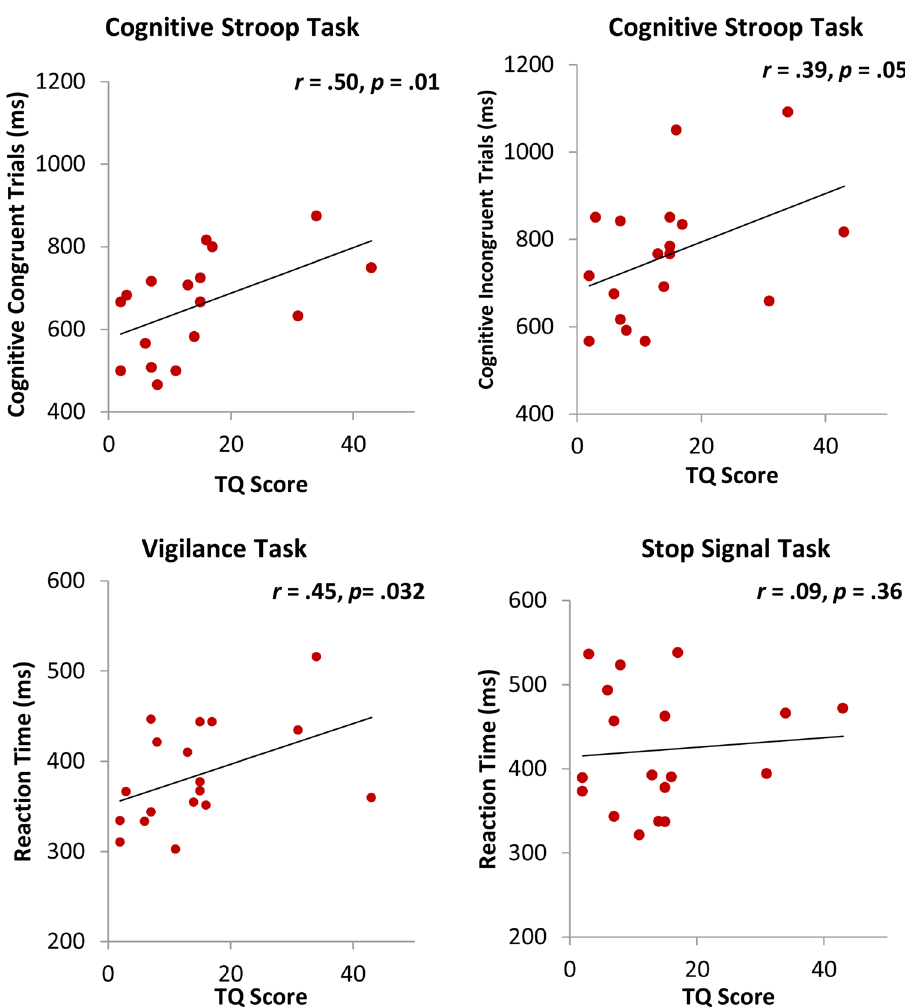
Figure 4. Correlation analysis between TQ scores and reaction times for the different tasks. ( A ) Congruent trials of the cognitive counting Stroop task, ( B ) Incongruent trials of the Cognitive counting Stroop task, ( C ) Vigilance task, and ( D ) Stop-Signal task.